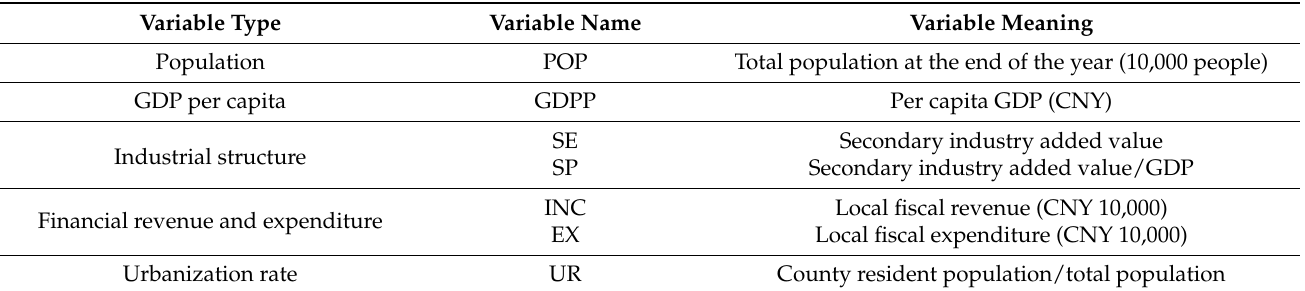
Table 2. Influencing